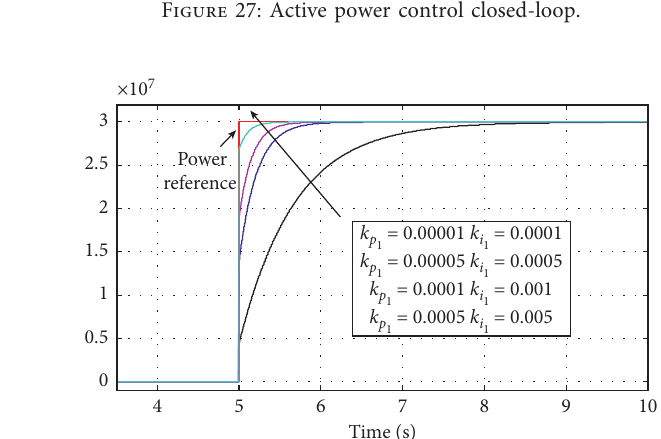
Figure 28: Time domain response of the active power control closed-loop to the step signal with different k